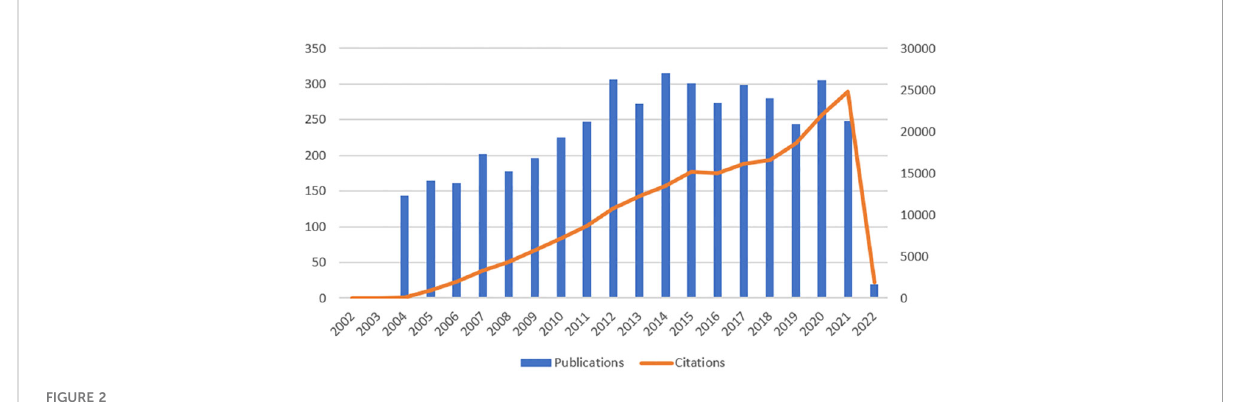
FIGURE 2 Trends in the growth of publications and the number of citations.